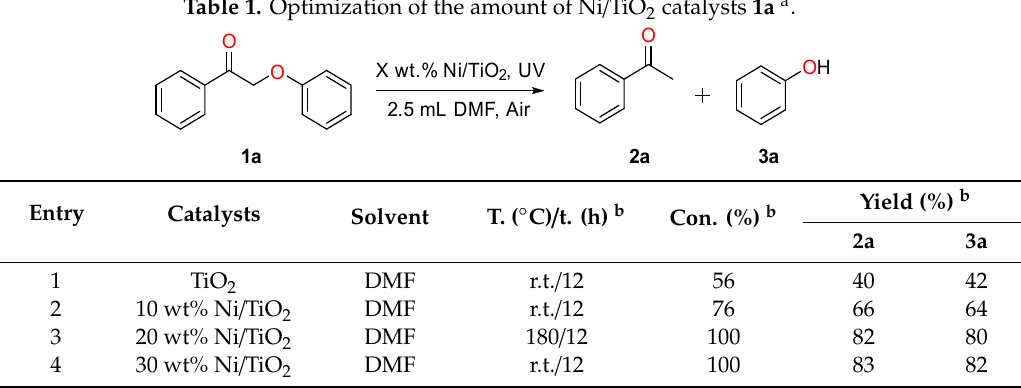
Table 1. Optimization of the amount of Ni/TiO 2 catalysts 1a a .